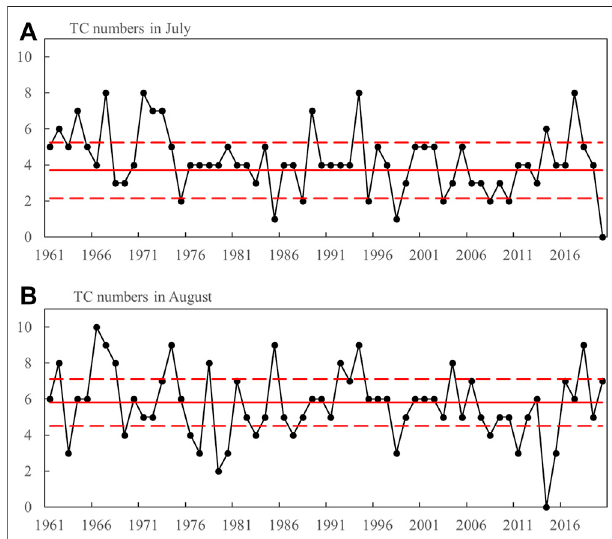
FIGURE 1 | Numbers of TCs that generated over the western North Paci fi c (0 ° – 25 ° N, 100 ° E – 180 ° ) (black line) in (A) July and (B) August during 1961 – 2020. Red solid and dashed lines indicate the climatological mean and one standard deviation of TC numbers,